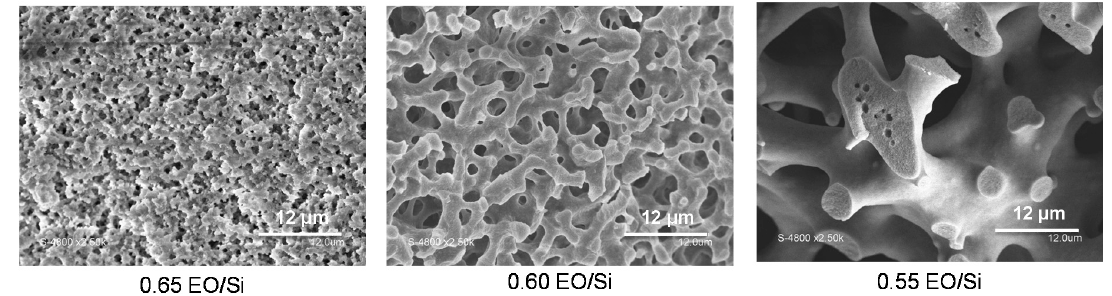
1. Figure 2. 换成这个